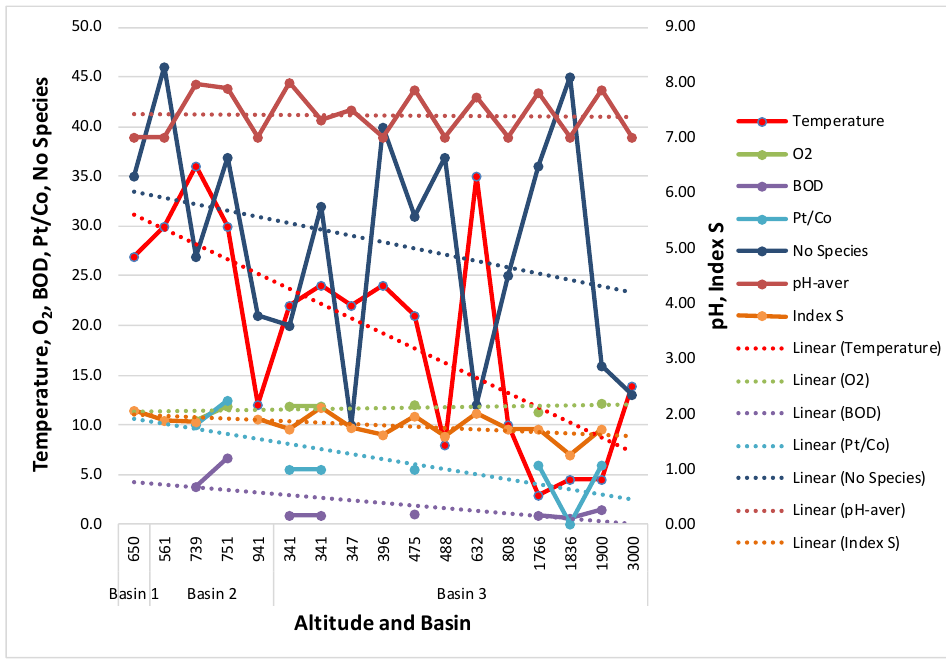
Figure 3. Dynamics of environmental and biological variables along the altitudinal gradient of study sites. Dashed lines are linear trend lines.